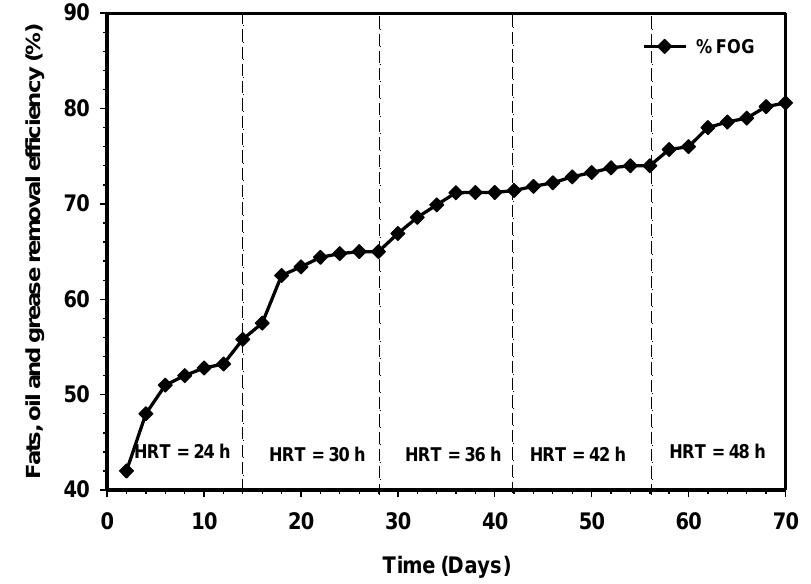
Figure 11. Variation of fats, oil, and grease (FOG) removal relative to increasing contact time .